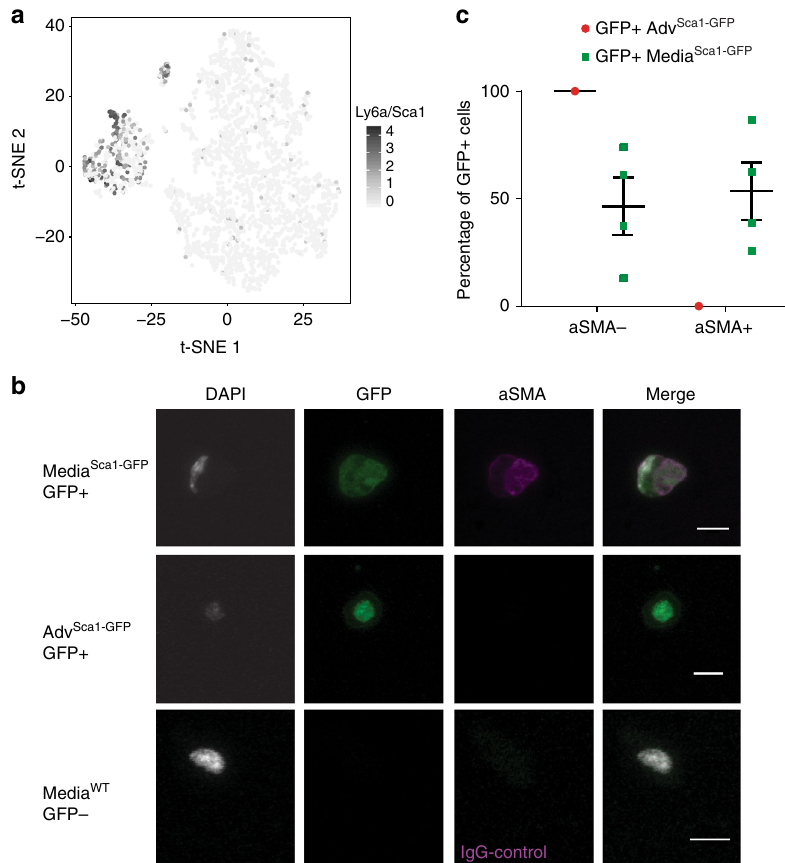
Fig. 5 A subset of medial cells express Sca1. a t-SNE plot visualising the 10X Chromium dataset of unselected cells from whole aortas (shown in Fig. 4d), with log-transformed expression levels of Ly6a/Sca1 in each cell colour-coded on a scale from light to dark grey. b Representative confocal images of GFP- positive cells isolated from the media (top row) or adventitia (Adv, middle row) of Sca1-GFP animals after immunostaining for aSMA. Signals for GFP (green), anti-aSMA (magenta) and nuclear DAPI (white) are shown individually and merged as indicated. The lower row shows GFP-negative medial cells isolated from wild-type animals and stained with isotype IgG as a control for staining and GFP detection. Scale bars are 10 µ m. c Dot plot showing the percentage of aSMA – and aSMA + cells in sorted GFP + adventitial (Adv, red dot, n = 1) and medial cells (green dots, n = 4) from Sca1-GFP animals. Data for individual replicates and their mean values are indicated and error bars show